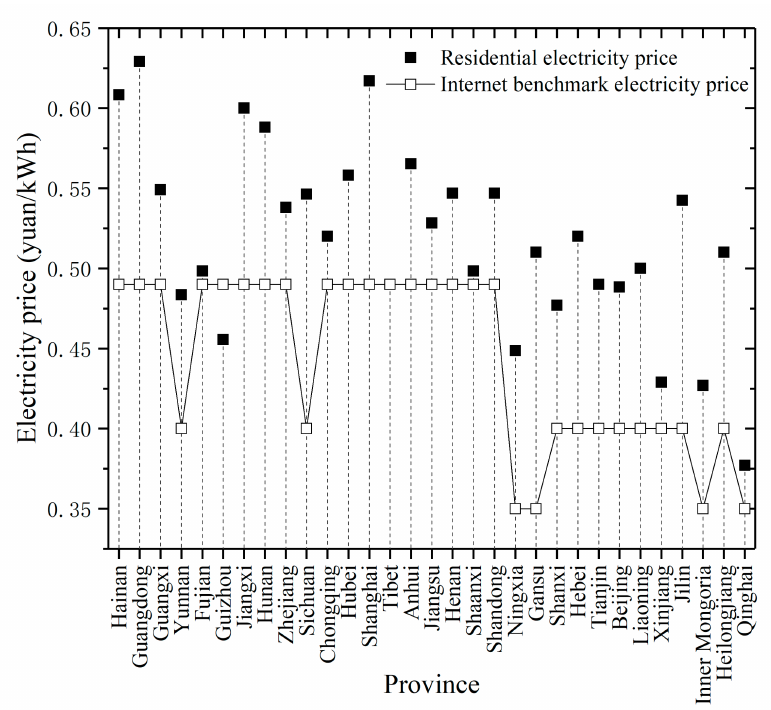
Figure 12. China’s residential electricity price and photovoltaic on-grid price in